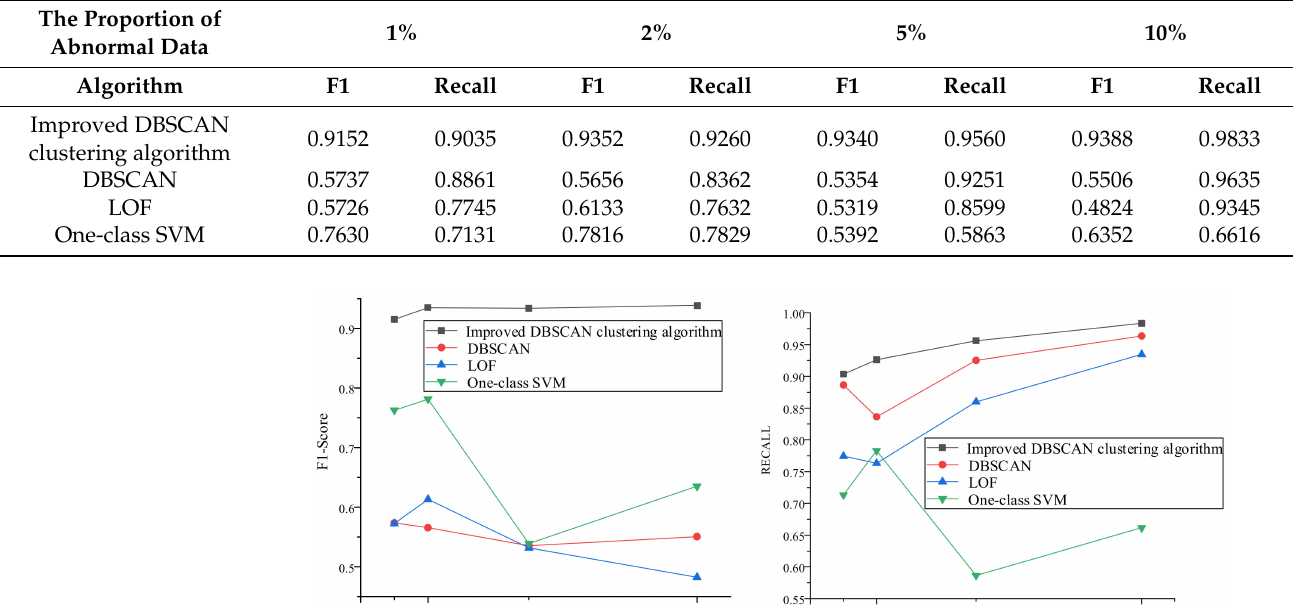
Table 4. Comparison of simulation results to other algorithms in the literature.